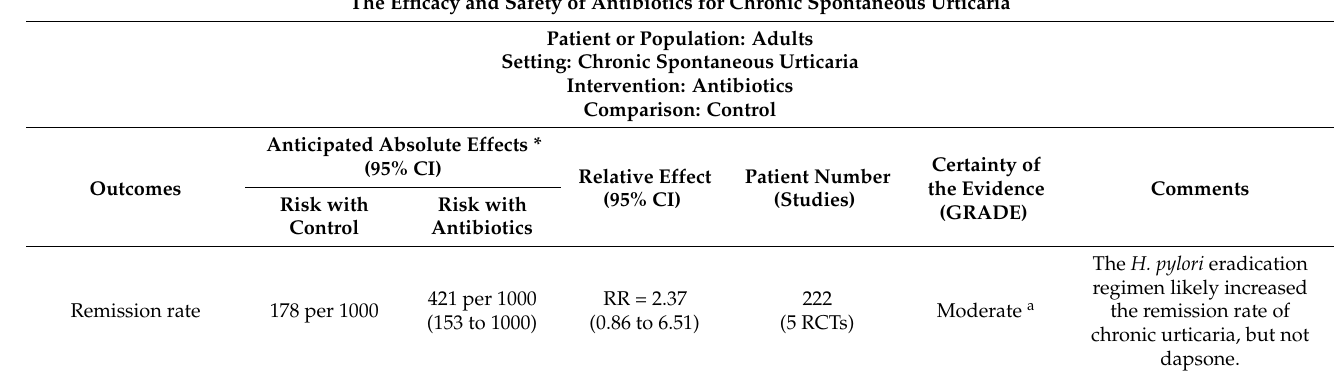
Table 3. Summary of